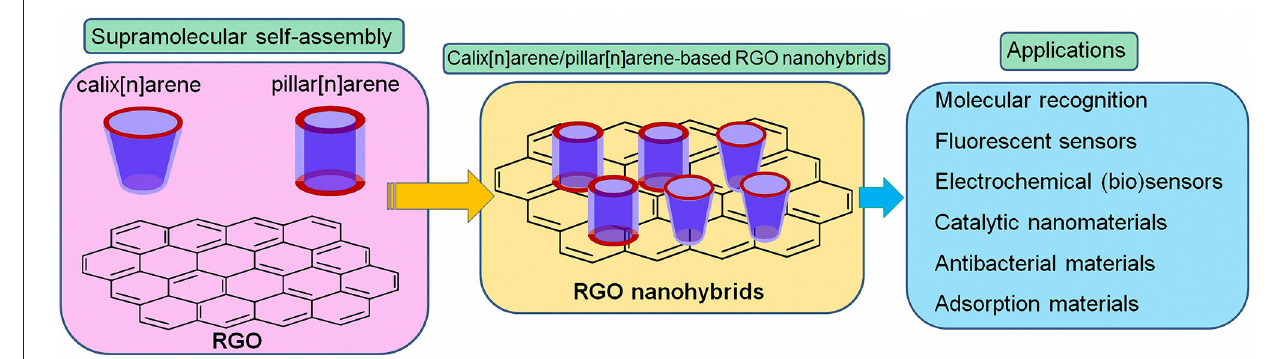
Figure 2 . Besides, the potential and challenges of the study of calix[n]arene/pillar[n]arene-functionalized